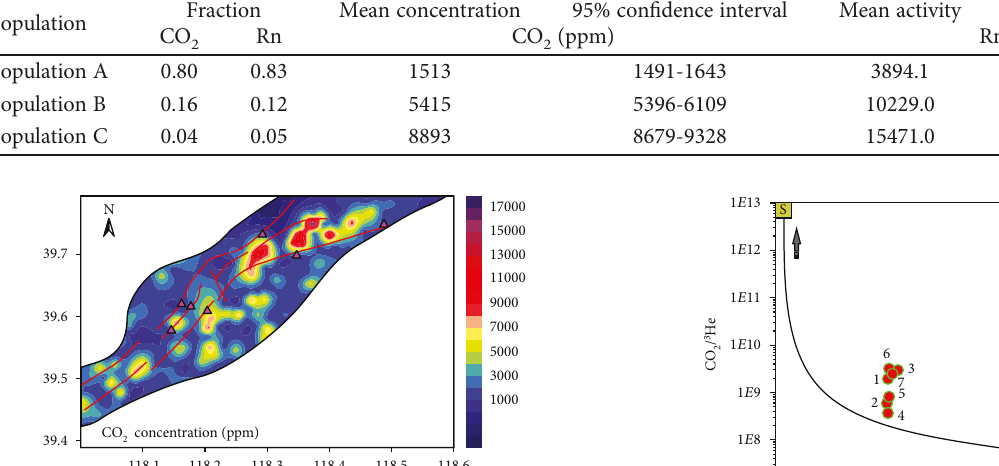
concentrations and Rn volume activities at the mobile measurement points. 2